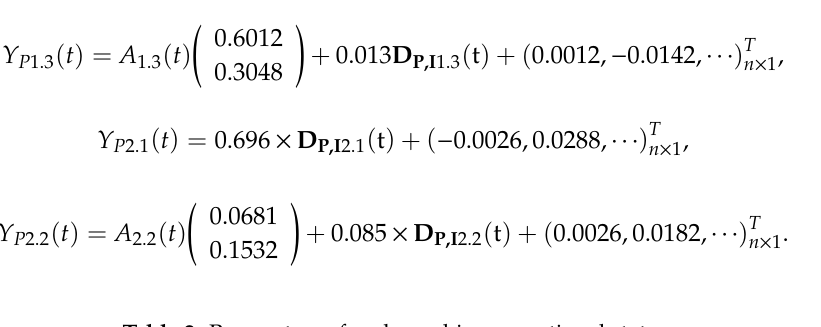
Table 2. Parameters of each machine operational